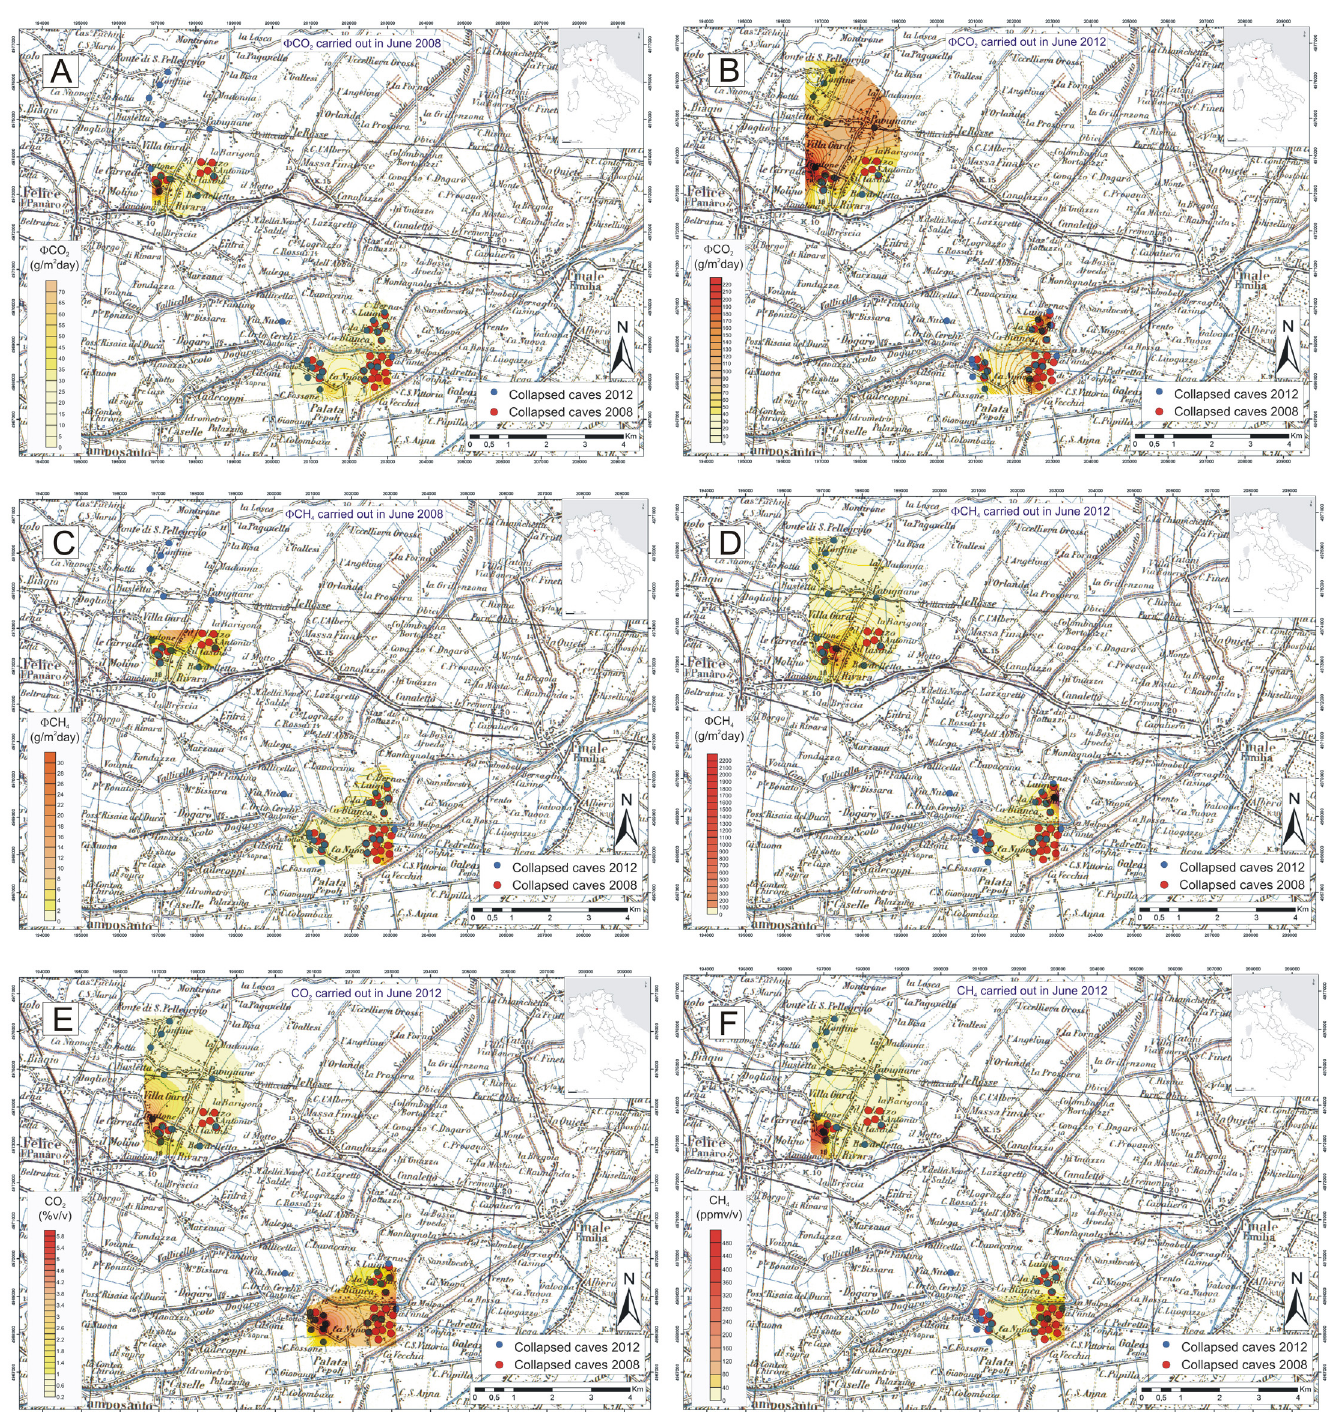
measured in 2008 and 2 concentrations measured in 4